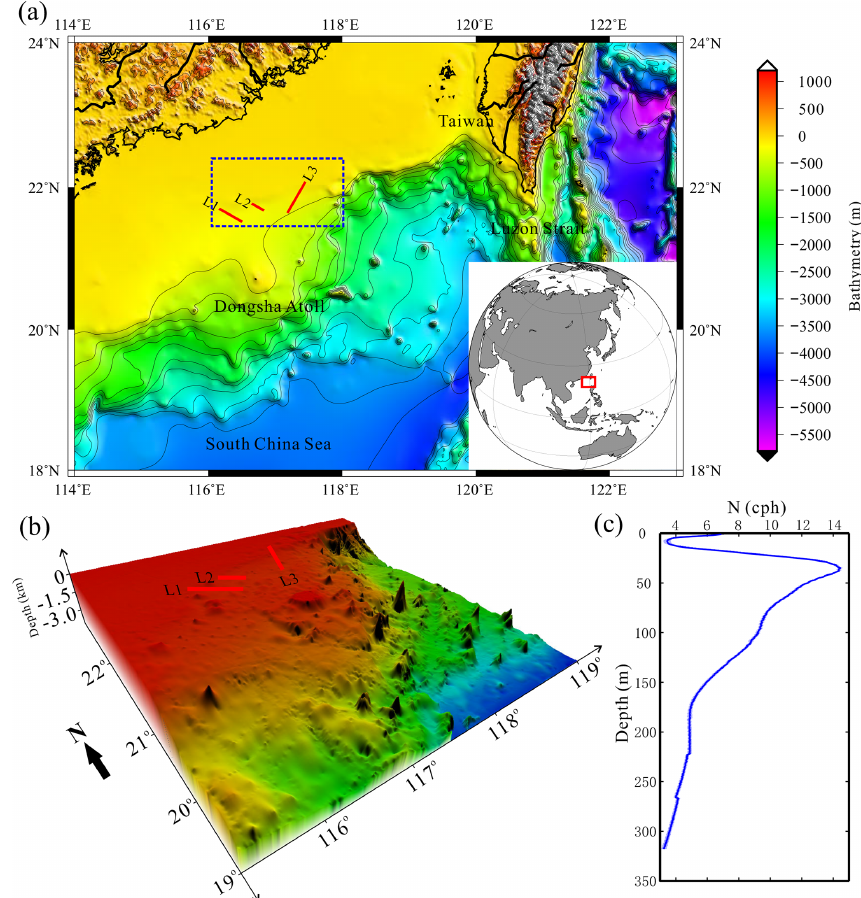
Figure 1. Bathymetry of the Dongsha area and locations of seismic survey lines. (a) Two-dimensional bathymetric map of the northeastern South China Sea, with the red lines representing the seismic survey lines. (b) Three-dimensional bathymetric map around the Dongsha Atoll. (c) The mean buoyancy frequency (cph: cycles per hour) around seismic survey lines (blue box in a ) and its 95% confidence interval (blue